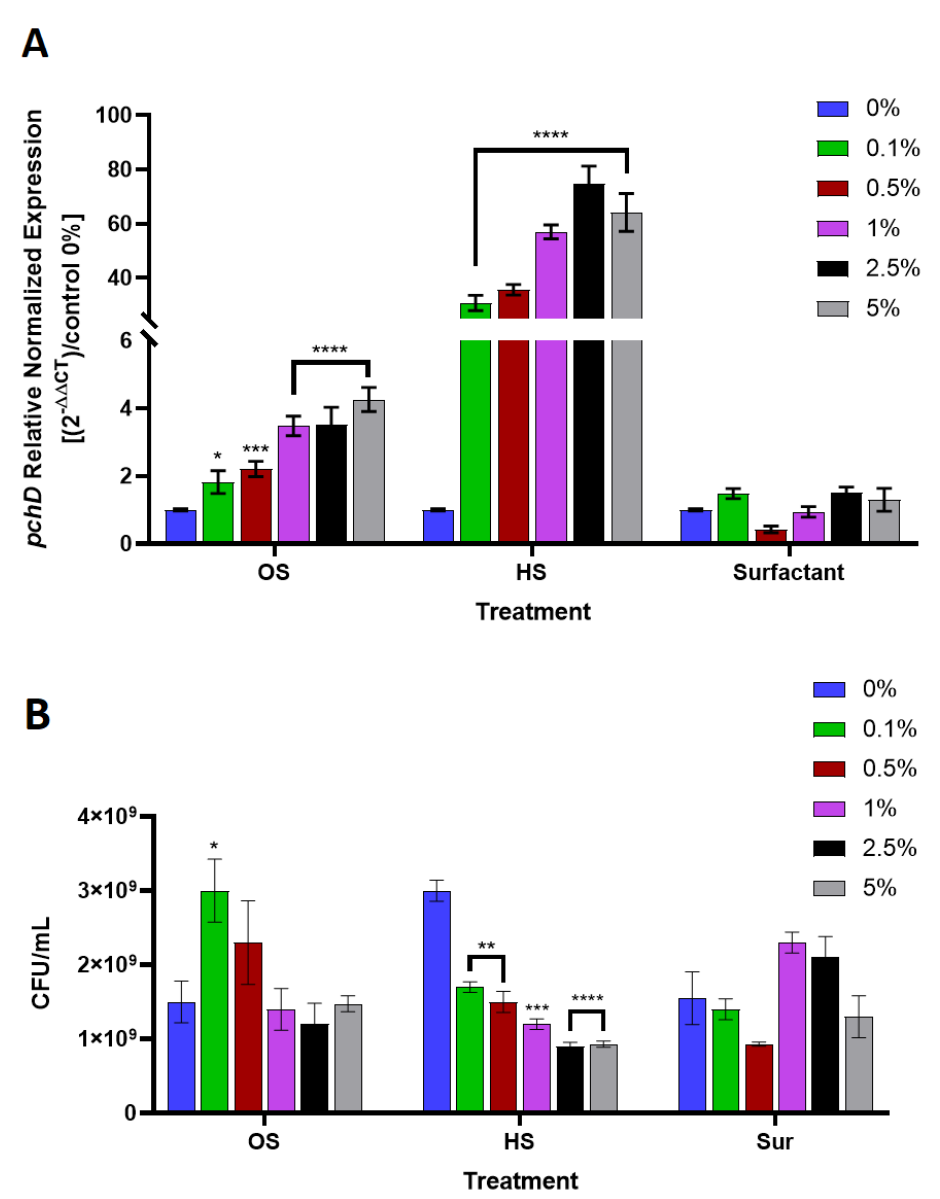
Figure 5. Burkholderia cepacia pchD gene expression during the treatment with subinhibitory concentrations of octyl salicylate (OS) and homosalate (HS). ( A ) Increasing concentrations of OS and HS were added to a B. cepacia culture and incubated ON. pchD gene expression was assessed against the recA housekeeping gene. The surfactant used to dissolve the compounds into the growth medium act as an additional control. Data are presented as 2 − ∆∆ CT normalized expression levels to the 0% negative control treatment, ± SD. ( B ) Viability of B. cepacia was documented for each treatment while data are presented as mean CFU / mL ± SD. Significant di ff erences in comparison to the control treatment (0%), are indicated in the graph ( p -value * < 0.05, ** < 0.01, *** < 0.001, **** < 0.0001).